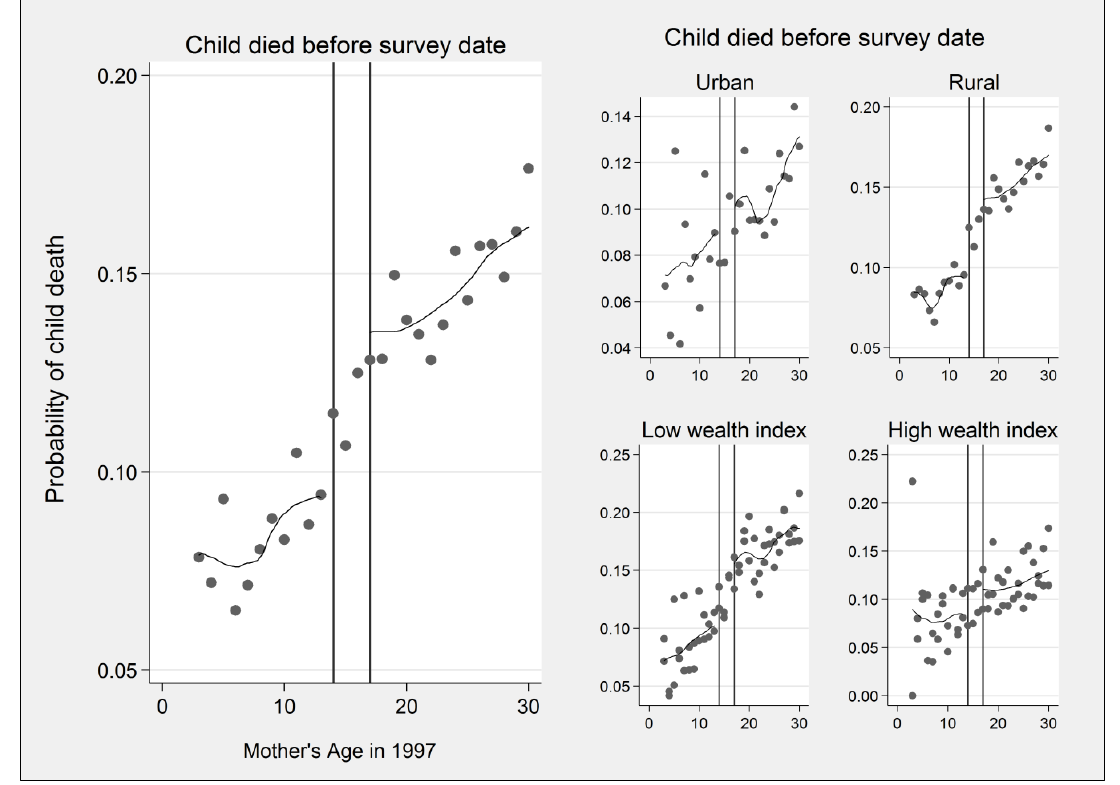
Figure 5. The impact of universal primary education on child mortality for the overall sample (left panel), urban or rural and household wealth status.